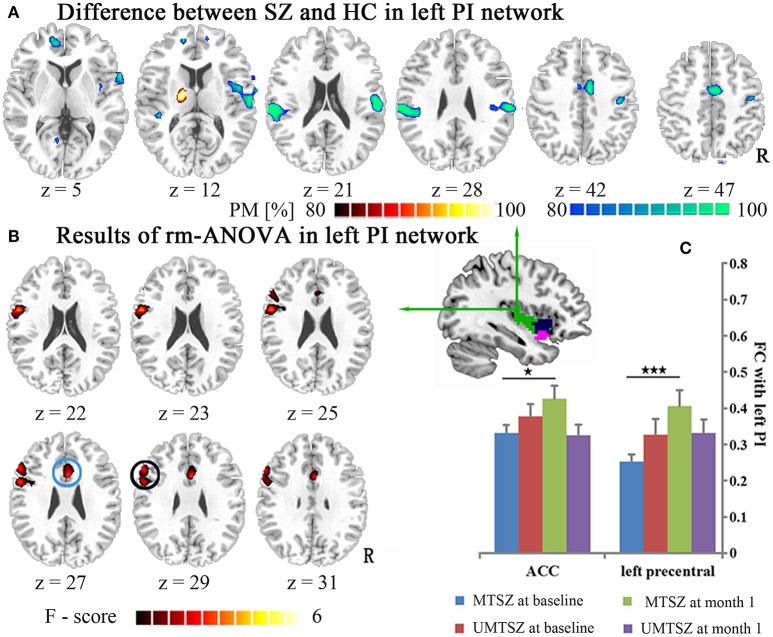
Music intervention * time interaction effect on the FC of the left PI. (A) Denotes the altered FC in the patients compared with the HCs. The cool color indicates decreased FC, and the hot color indicates increased FC. The maps are shown with probability score between 80 and 100%. (B) Denotes the significant music intervention * time interactions that were observed in the left PI-ACC FC and the PI-left precentral FC. (C) The bar maps present the FC differences between-group and within-group. The data are expressed as the mean value + standard error. *p < 0.05, ***p < 0.001. PM: probability map. The circles mark in (B), which represent the positively modulated region through music intervention in patients in (C) (blue circle: ACC; black circle: left precentral).